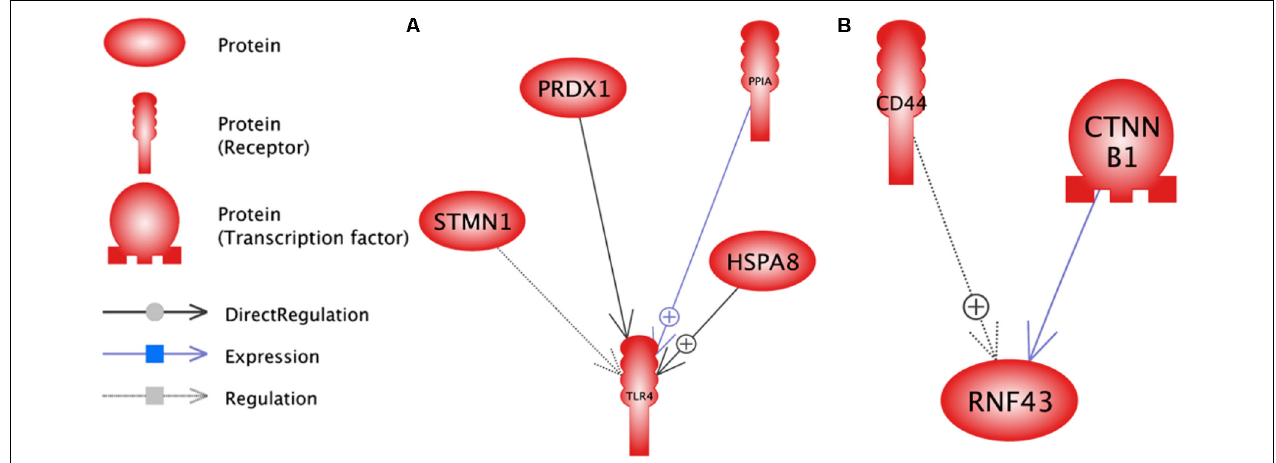
FIGURE 9 | Enriched sub-networks in down-stream neighbors of differentially expressed genes in lactation process; (A) Down-regulated genes, (B) Up- regulated genes.